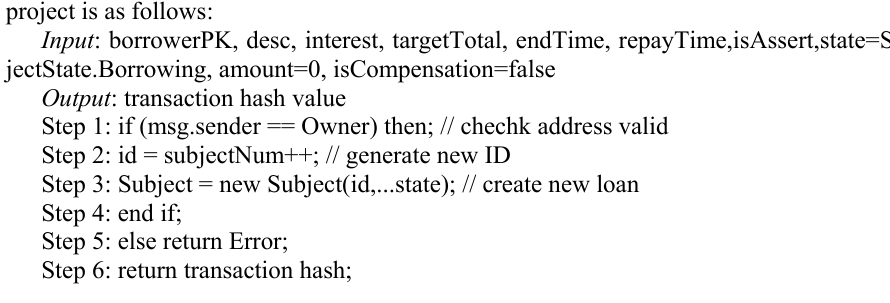
Table 1. Loan information